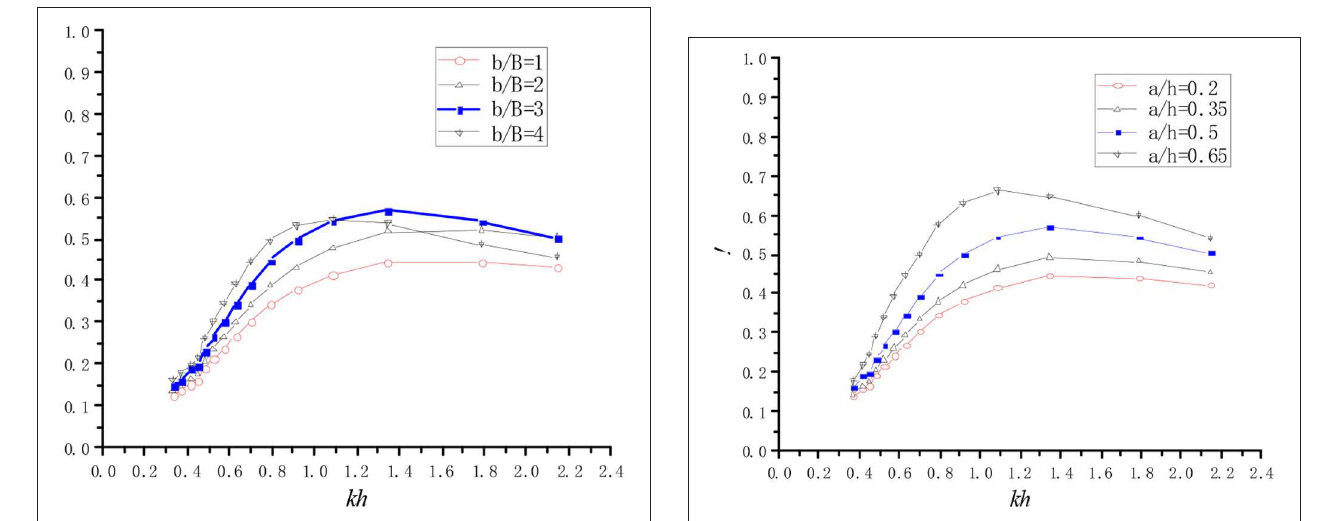
FIGURE 9 | Hydrodynamic conversion efficiency vs. dimensionless wave number for different step length.